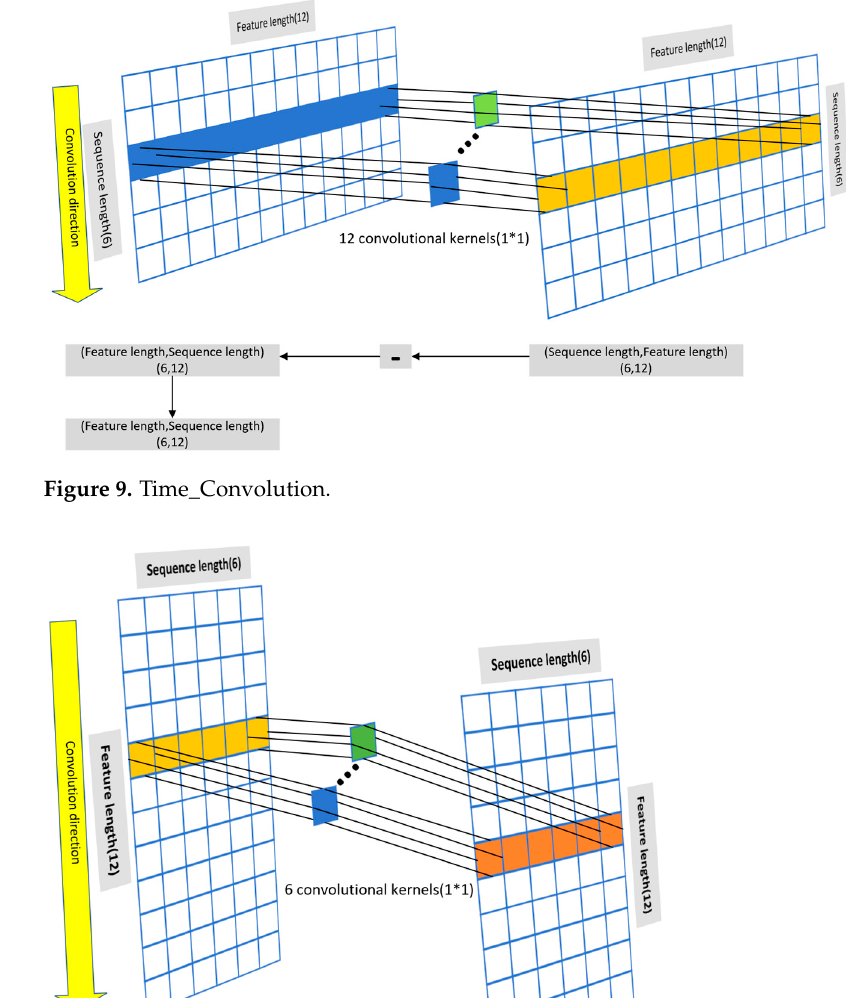
Figure 11. Festure_Boot.